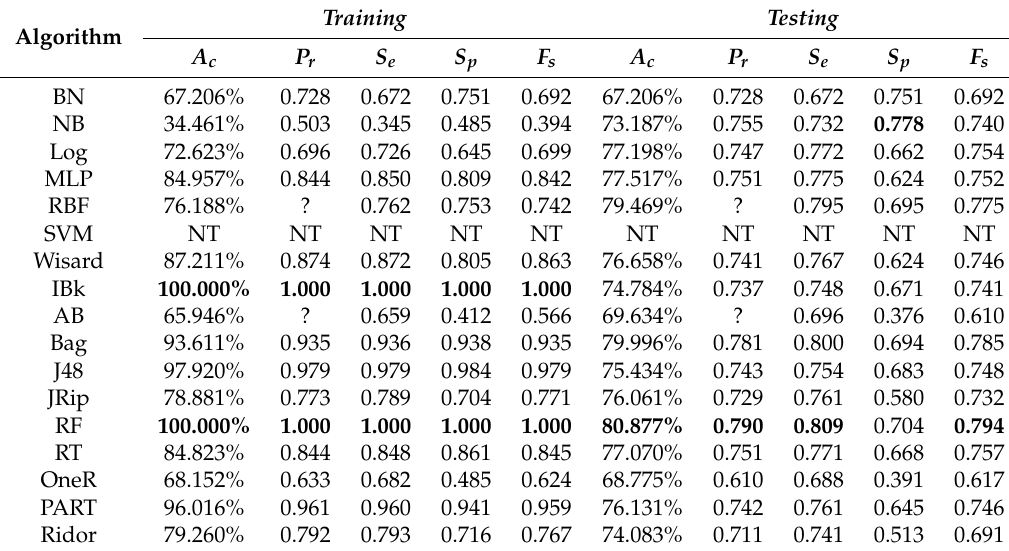
Table 3. The results of the